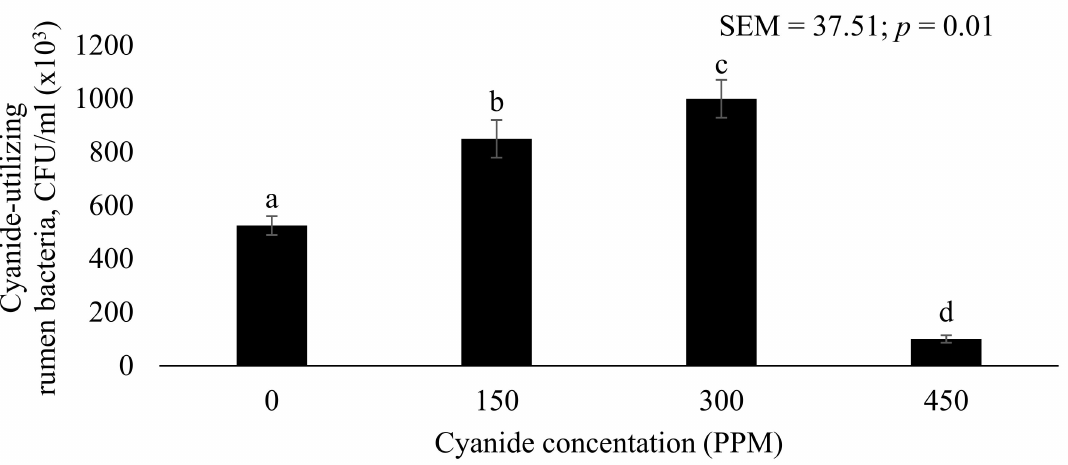
Figure 1. Cyanide-utilizing rumen bacteria growth curve at 0, 150, 300, and 450 ppm initial cyanide